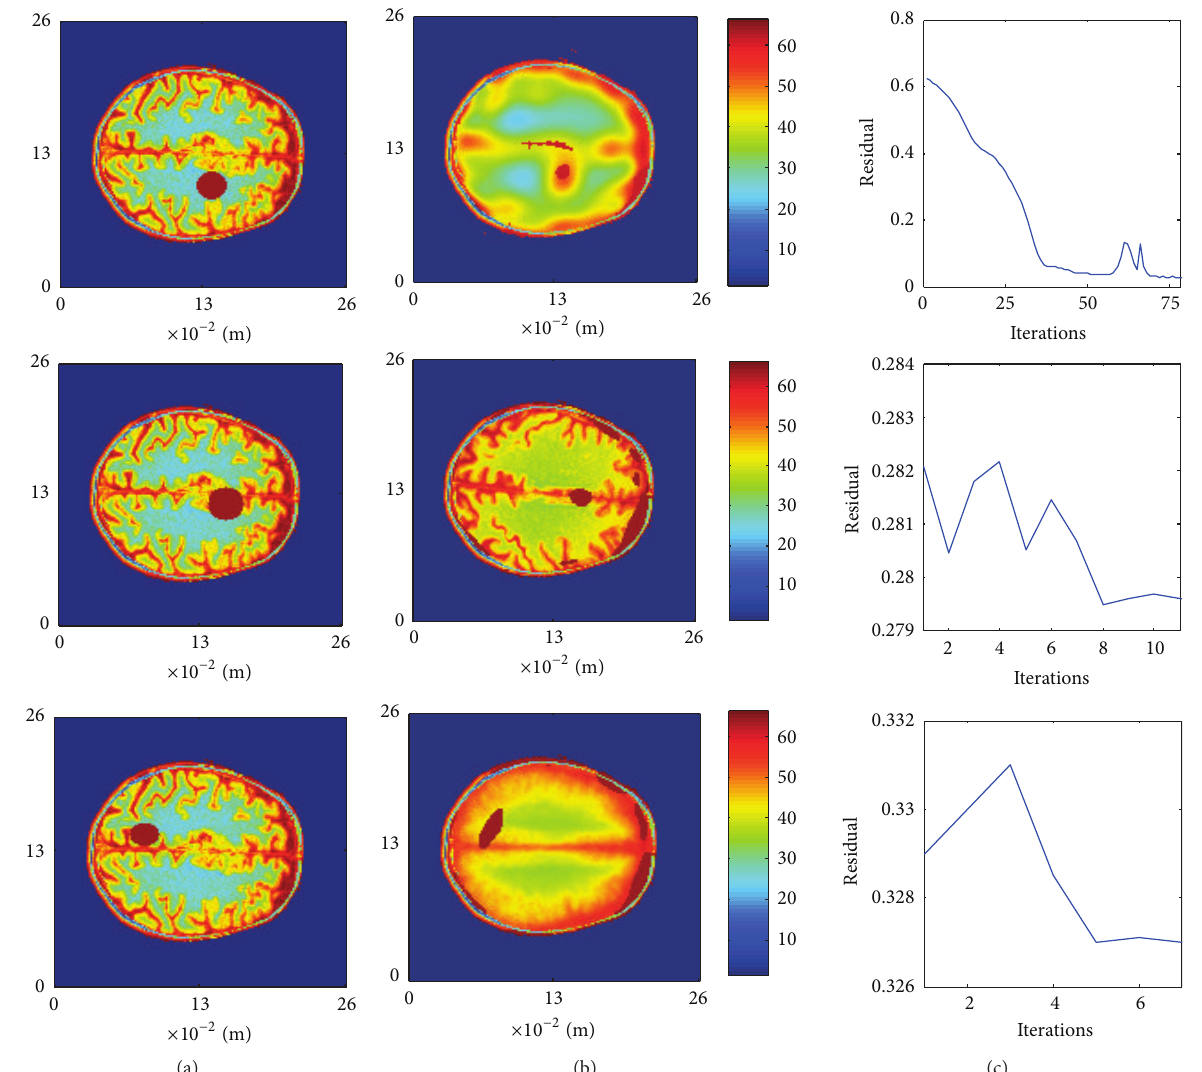
Figure 3: Comparison of the results obtained with the proposed initial guesses. The left column is the patient’s brain configuration, the central column depicts the results of reconstruction, and the right column shows the residuals evolution. The rows correspond, from upper to lower, to the ADC-PPS, RM, and AMM initial